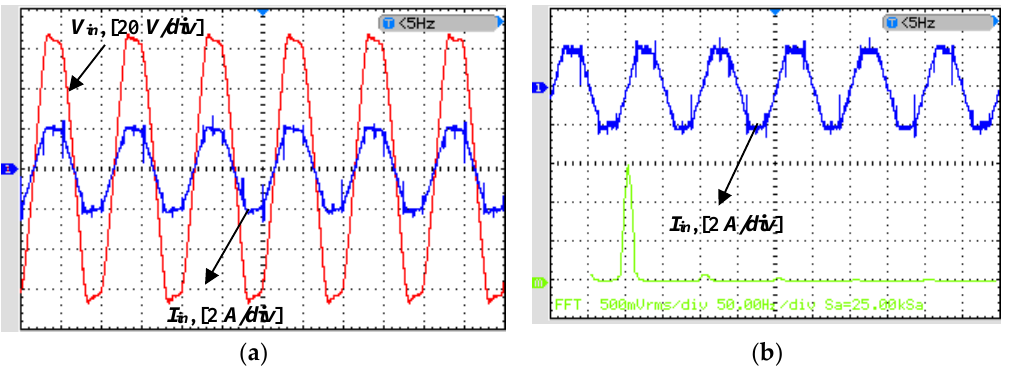
Figure 12. ( a ) Input current (blue) with reference of input voltage (red) in boost mode; ( b ) power quality analysis of the input current.